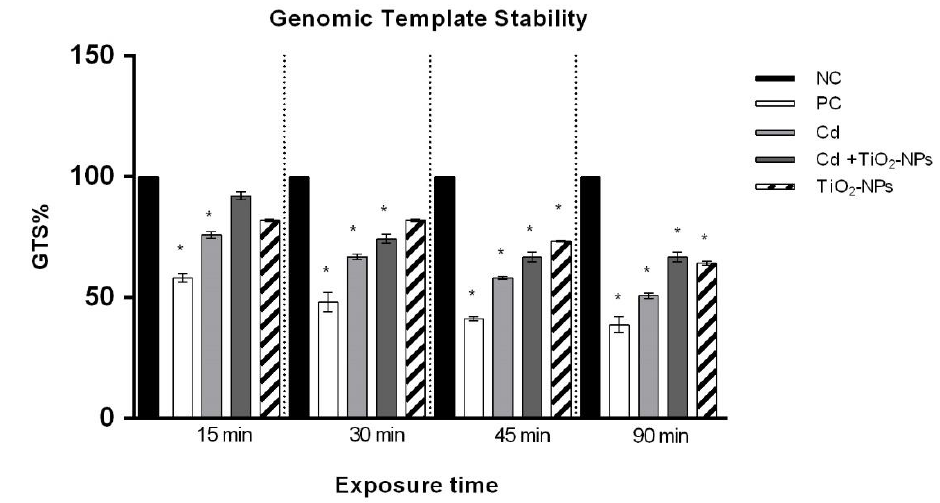
Figure 7. Changes in the percentage of Genome Template Stability in human sperm DNA (ordinate) after di ff erent exposure times (abscissa) to CdCl 2 and CdCl 2 + TiO 2 NPs co-exposure, as evidenced by the RAPD-PCR technique. The black bars are the negative controls (NC); the white bars are the positive controls (PC) (benzene 0.4 µ L / mL); the light grey bars are 10 µ M CdCl 2 -treated sperm (Cd); the dark grey bars are 10 µ M CdCl 2 + 1 µ g / L TiO 2 NPs-treated sperm (Cd + TiO 2 NPs); the striped bars are 1 µ g / L TiO 2 NPs-treated sperm. * p ≤ 0.01.